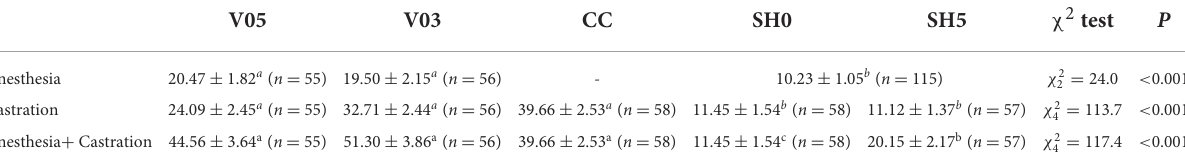
TABLE 7 Averages ( ± SE) of foreleg movements recorded during injection of local anesthetic and during castration.